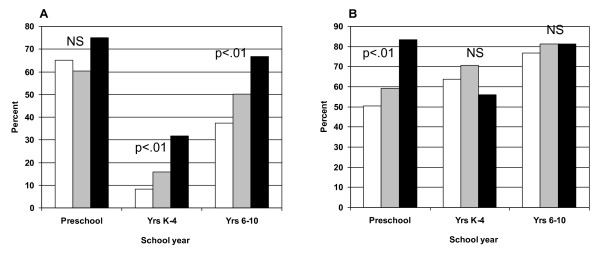
The proportion of children who do not meet guidelines for (A) physical activity or (B) screen time by the number of barriers reported by parents*. White bar 0-1 barrier. Grey bar 2-3 barriers. Black bar ≥4 barriers. *p-values derived from Chi-square test of independence